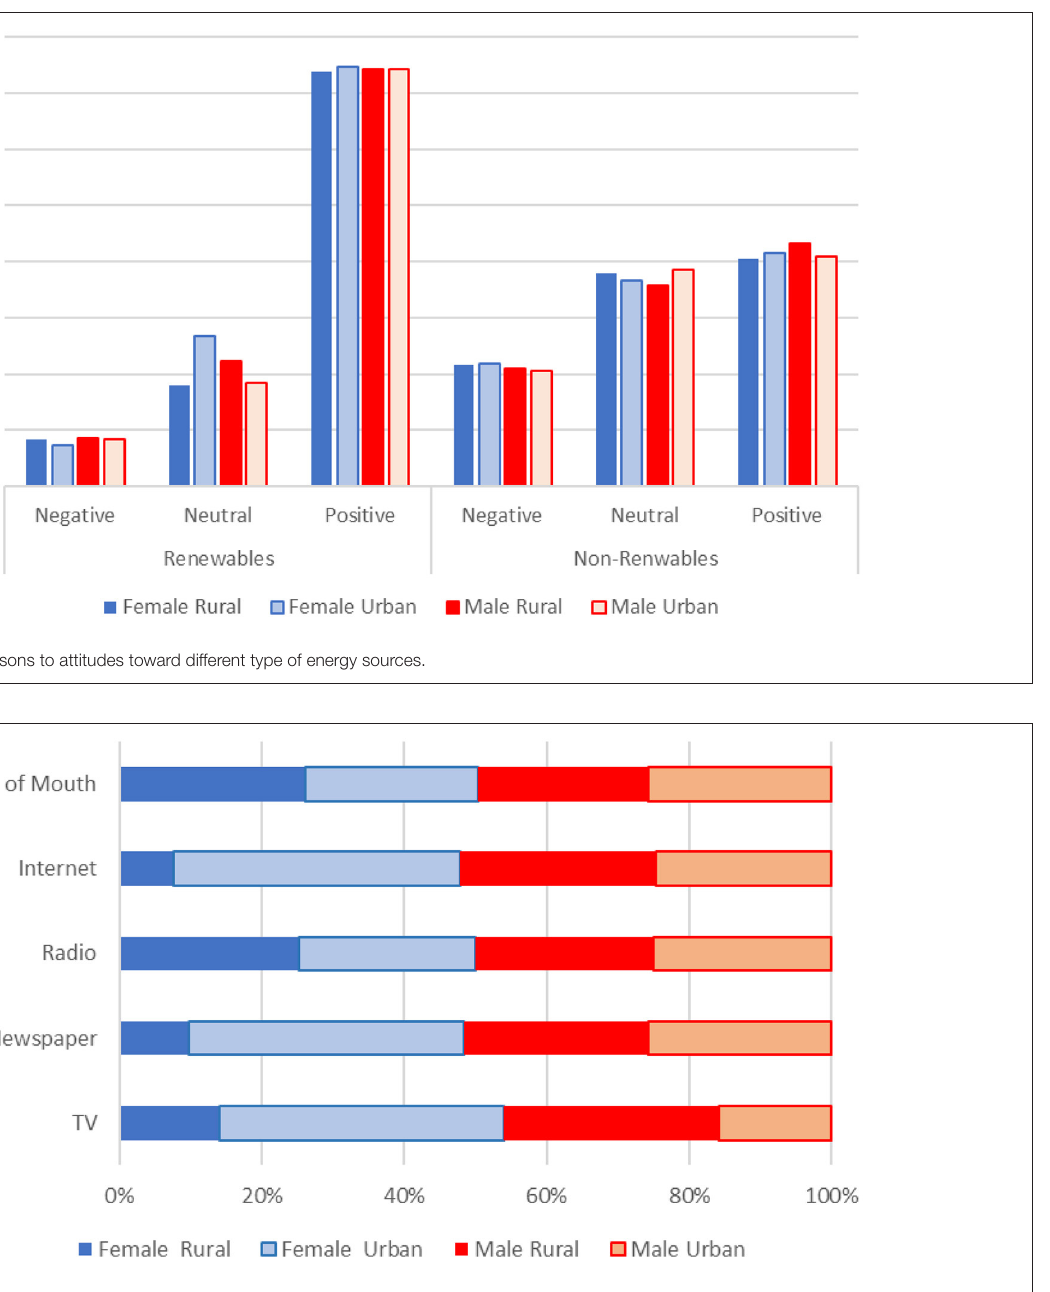
FIGURE 5 | Generally, where did you hear of the renewable energy